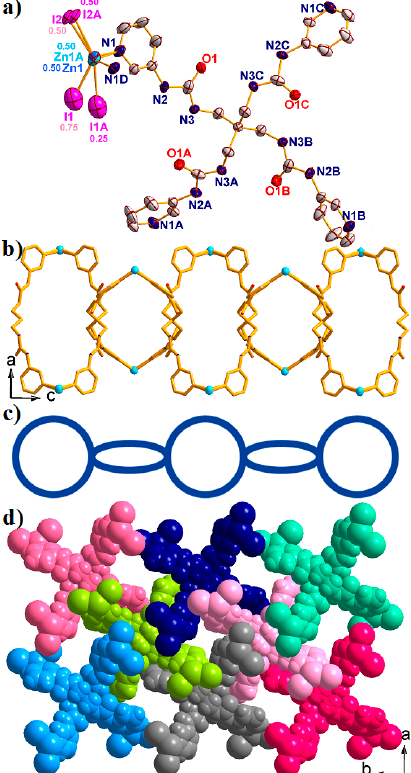
Figure 4. ( a ) The asymmetric unit of complex 3 with 50% probability ellipsoids. (Symmetry codes: